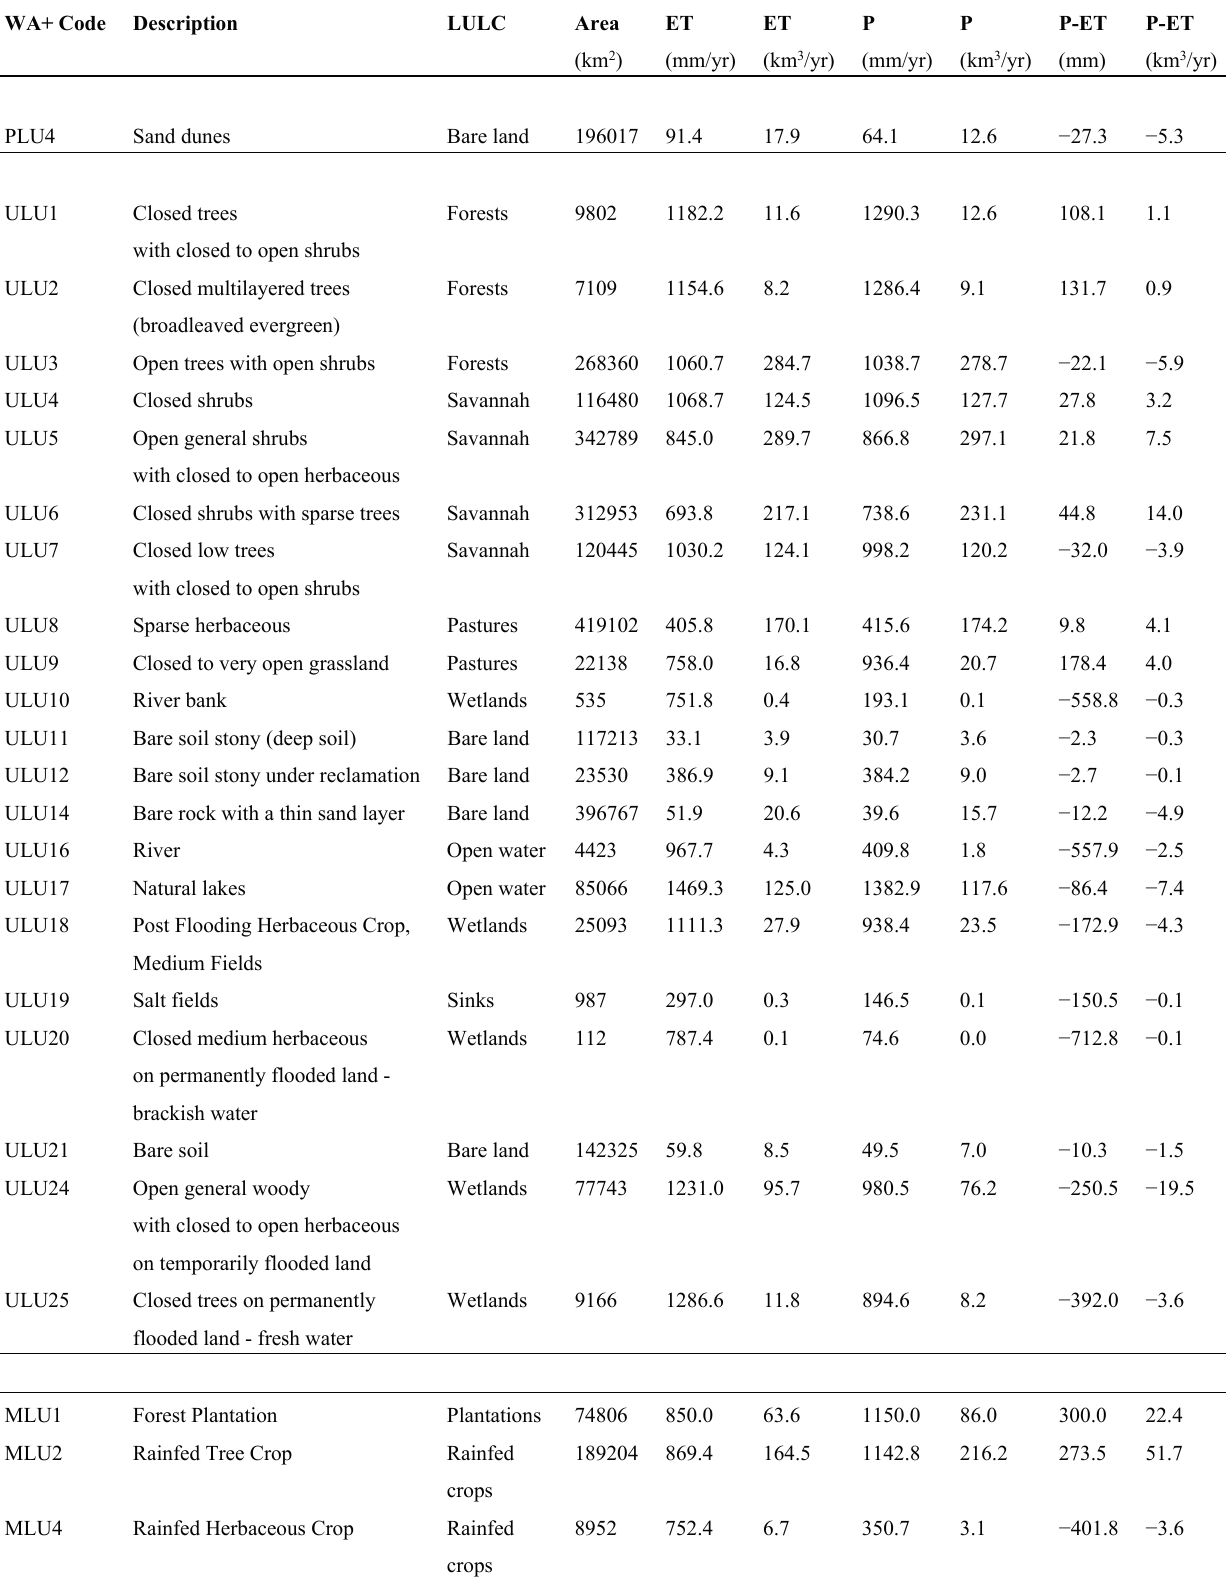
Table A1. Comprehensive list of rainfall and ET by land use-land cover class. The classes are coded by the standard defined by Water Accounting Plus